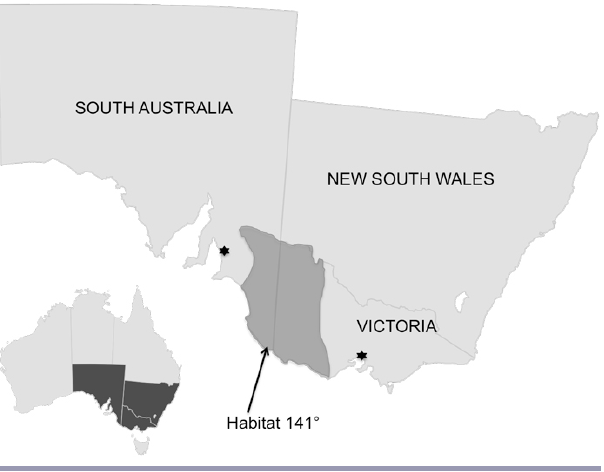
Fig. 3 . Habitat 141°, situated along the Victorian South Australian border in southeastern